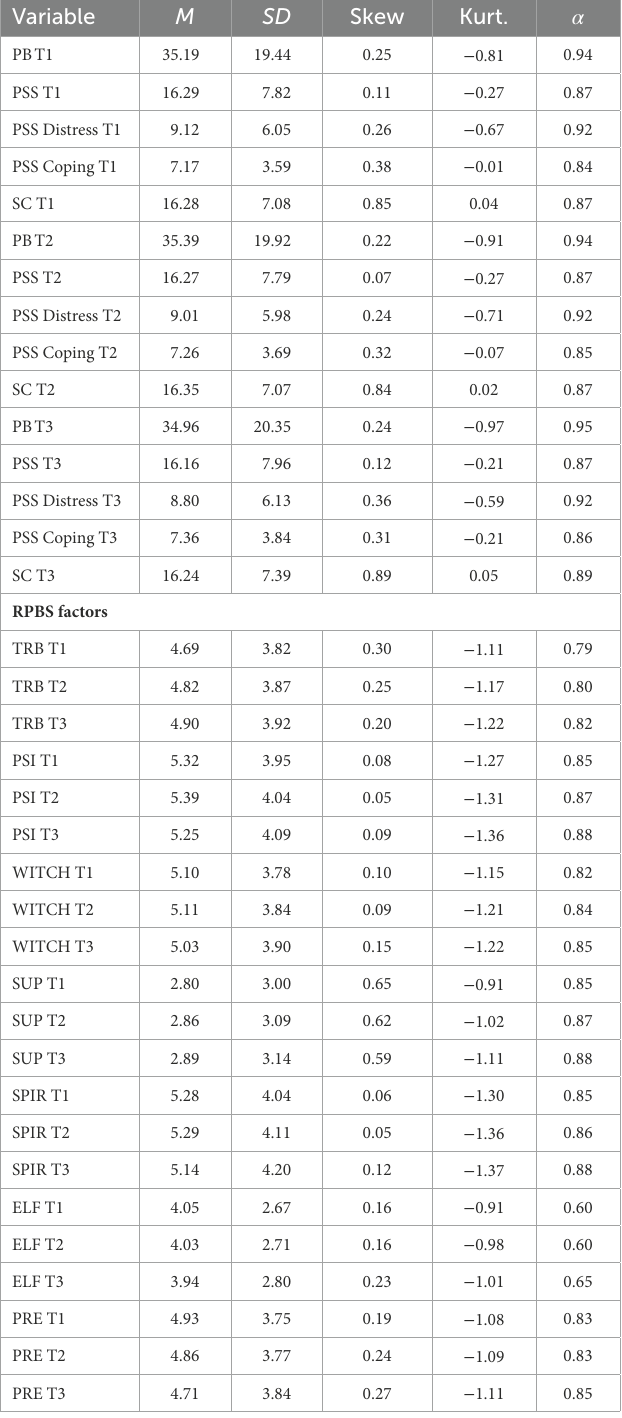
TABLE 1 Descriptives and reliability for RPBS, PSS, PSS factors, SSS-8 and RPBS factors.